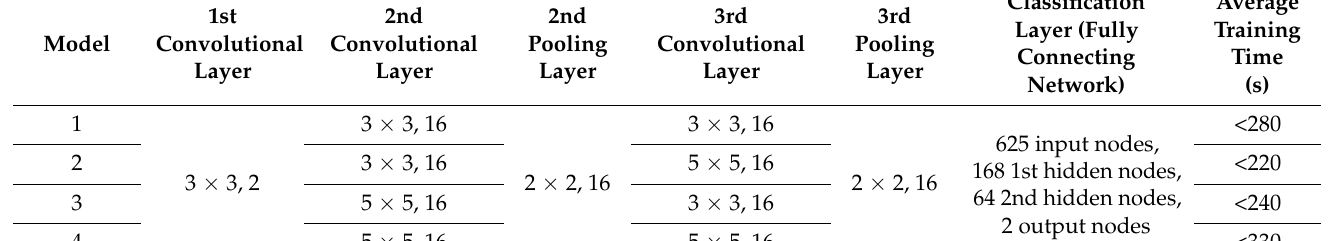
Table 6. Comparisons of the training CPU time for different models of multilayer CNN-based classifier.